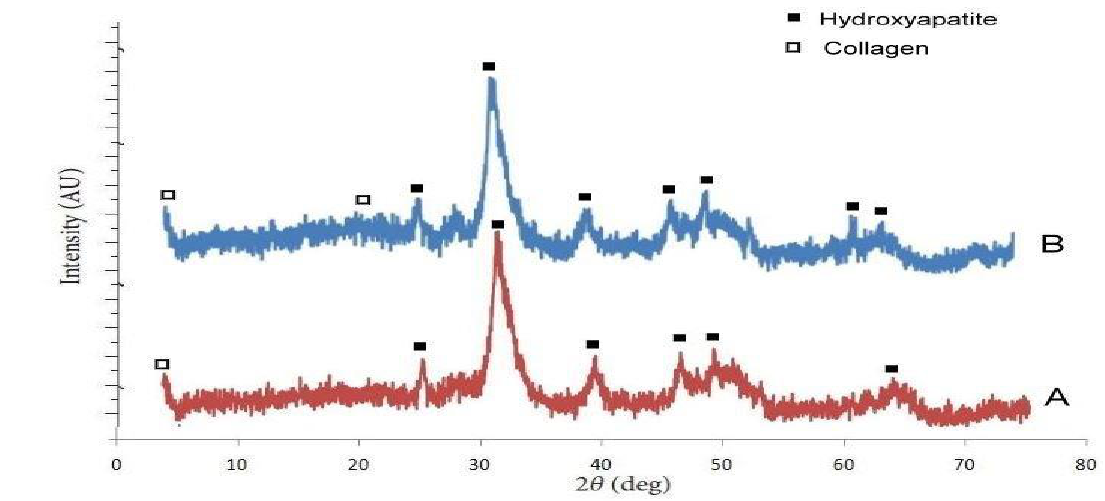
Fig. 5. X-Ray Diffraction (XRD) pattern of raw (A) bovine bone and (B) caprine